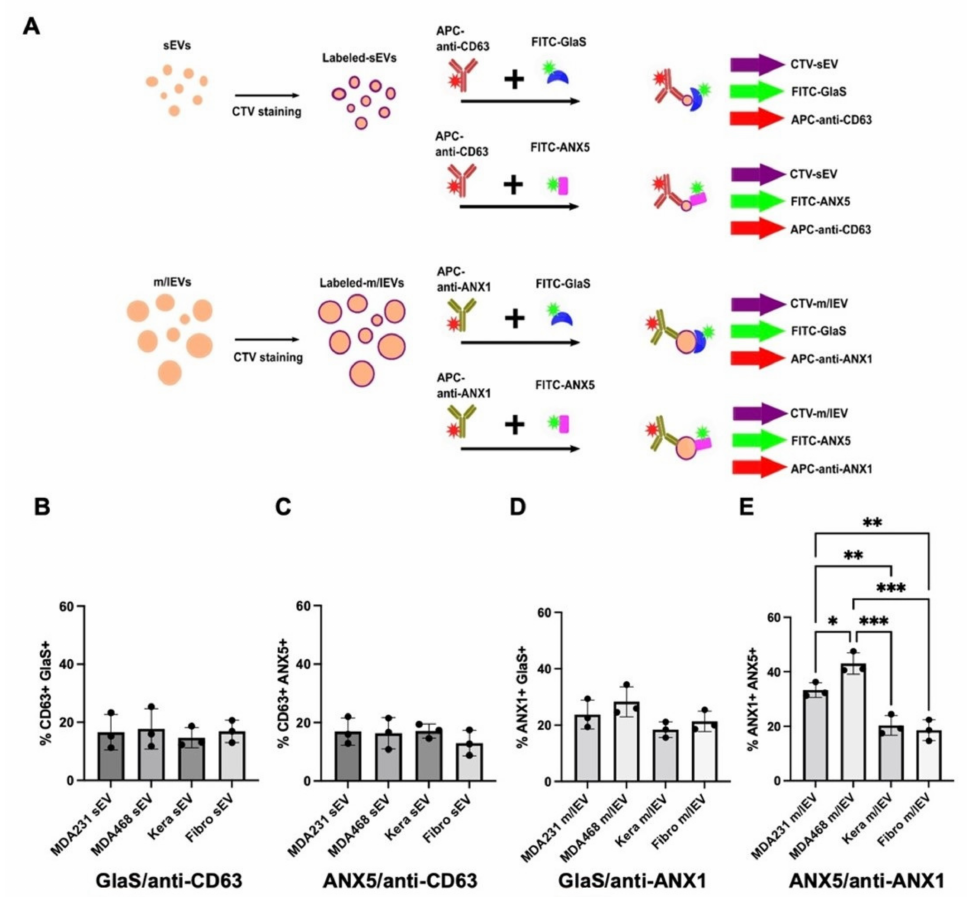
Figure 4. Single EV analysis of phosphatidylserine (PS)-exposing small EVs (sEVs) and medium/large EVs (m/lEVs). ( A ) A schematic diagram of EV labeling with CellTrace Violet (CTV), followed by incubating with antibodies against EV markers and PS-binding proteins. ( B , C ) CTV-sEVs were incubated with allophycocyanin (APC)-anti-CD63 antibodies and fluorescein isothiocyanate (FITC)- GlaS or FITC-annexin A5 (ANX5) proteins. ( D , E ) CTV-m/lEVs were incubated with APC-anti- annexin A1 (ANX1) antibodies and FITC-GlaS or FITC-ANX5 proteins. The graphs show % of the FITC/APC double-positive EV populations. Error bars, the standard deviation of three independent analyses, * p < 0.05; ** p < 0.01; *** p <